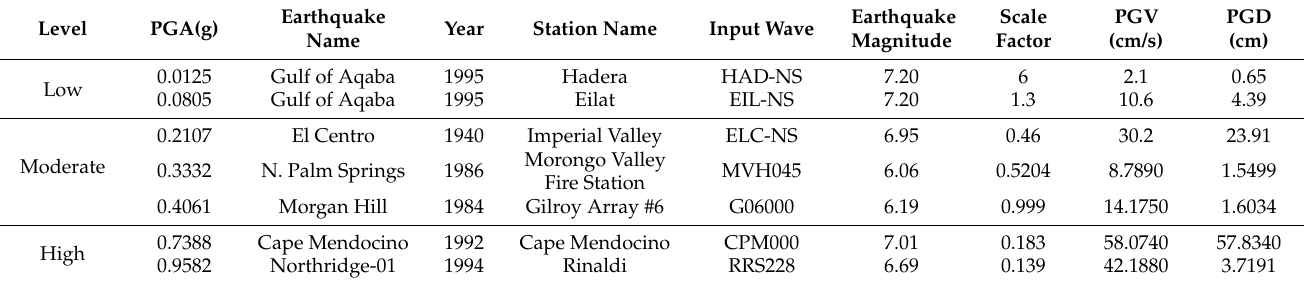
Table 1. Characteristics of time history acceleration records used in the analysis. (PGA: peak ground acceleration; PGV: peak. ground velocity; PGD: peak ground displacement).